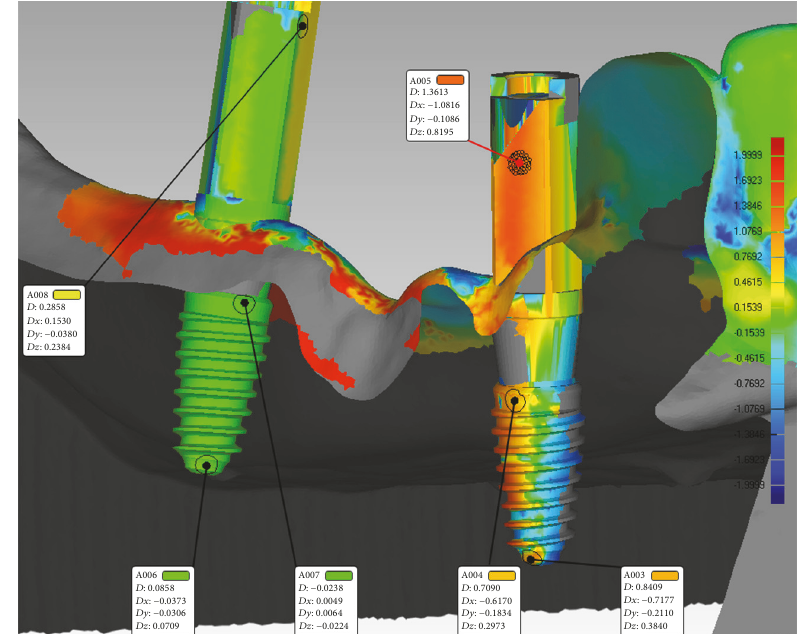
Figure 8: Qualitative color-codded graphical analysis of implants planned (reference) and placed (test) in Geomagic Qualify (cid:2) software.